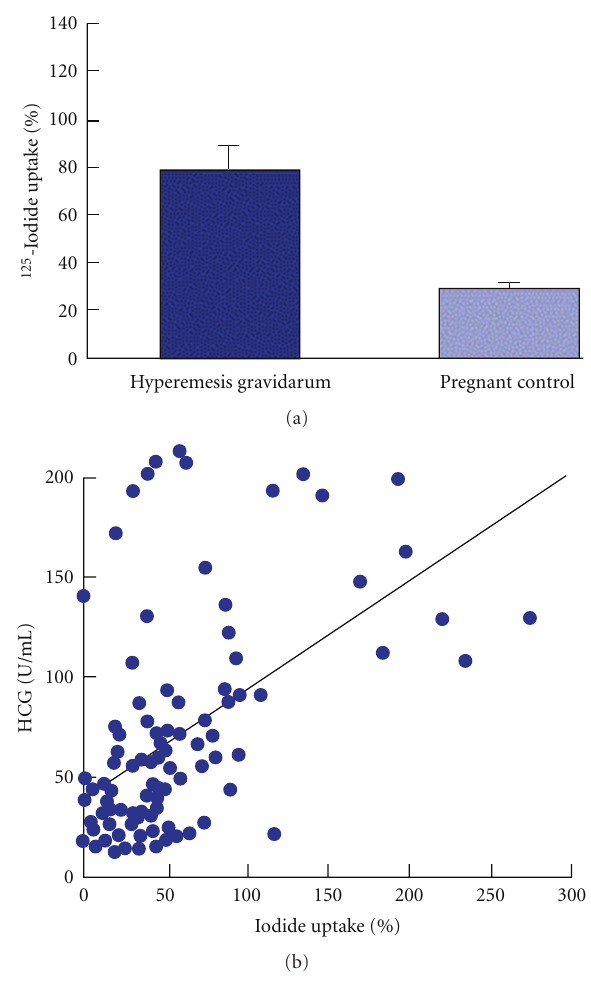
Figure 5: (a) Serum thyrotropic activity (measured as iodide uptake in cultured rat cells) in hyperemesis patients and pregnant controls, mean + SE, P < 0 . 001) (b) correlation of serum hCG versus serum thyrotropic activity in hyperemesis and pregnant controls, r = 0 . 50, P < 0 . 001 Goodwin et al.